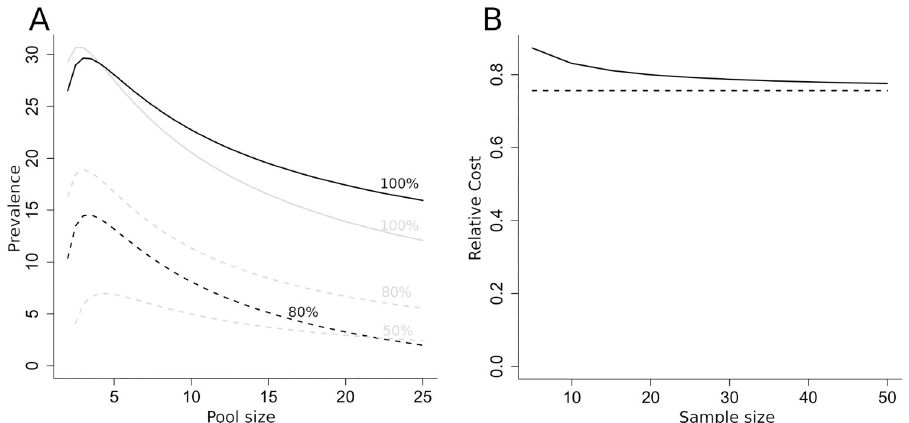
Fig 2. The effect of prevalence uncertainty on mean relative cost. A) Prevalence for expected relative cost of 100%, 80% and 50% with sample size of 10. Grey lines show relative costs for known prevalence, as in Fig 1A. Y axis indicates known underlying prevalence or mean prevalence from exploratory data when prevalence is unknown. B) Relative cost against exploratory sample size. Broken line shows relative cost when prevalence is known and set to the mean from the exploratory tests. (Mean prevalence 15%, pool size of 5).